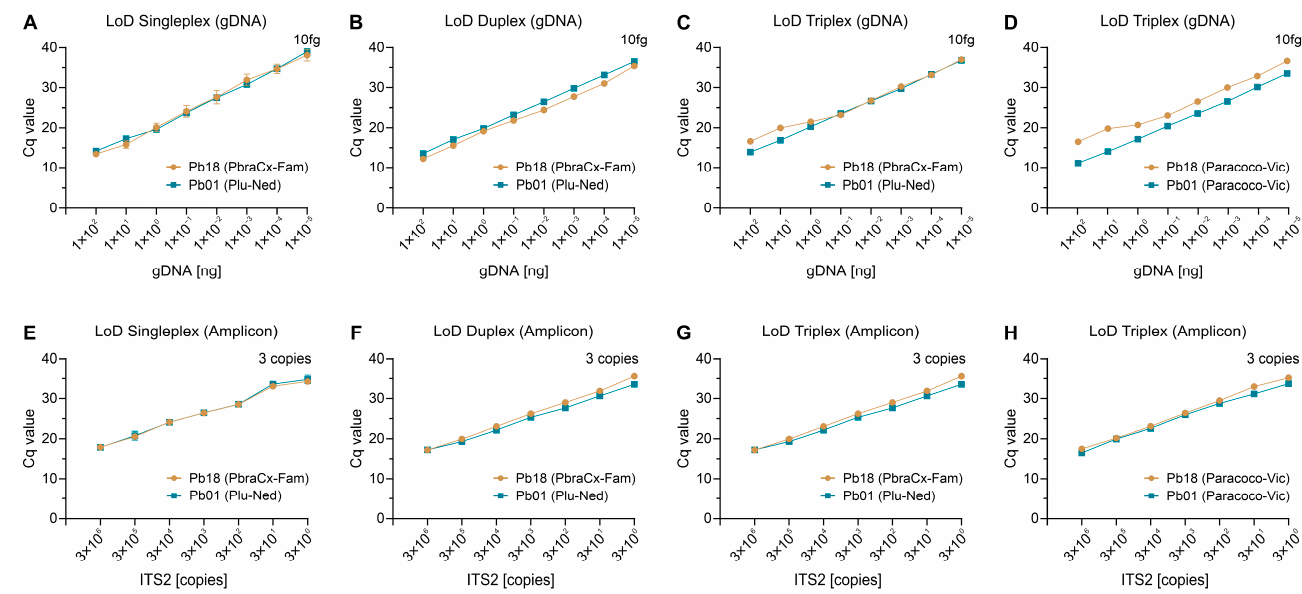
Figure 3. Assessment of analytical sensitivity of a singleplex- ( A , E ), duplex- ( B , F ), and triplex-probe qPCR assay ( C , D , G , H ). ( A – D ) For P. brasiliensis (Pb18) and P. lutzii (Pb01), the lower detection limit of gDNA was 10 fg, independent of the format. ( E , F ) For all species, the lower limit of detection of the ITS2 amplicon (amplified with primers Paracoco-F and Paracoco-R) was three copies. For each format, the detected probe appears in parentheses in the legend. The results are typical of two separate experiments.